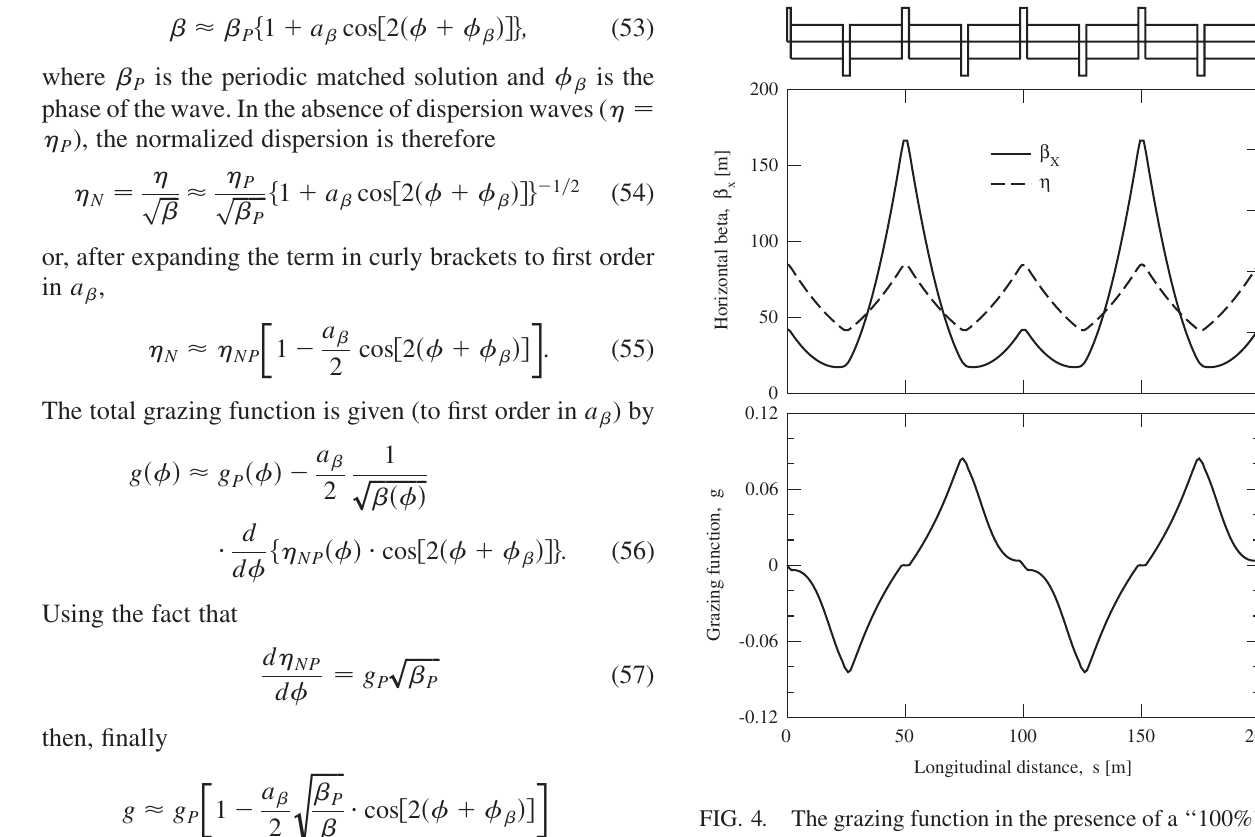
ffiffiffiffi p (cid:1) .